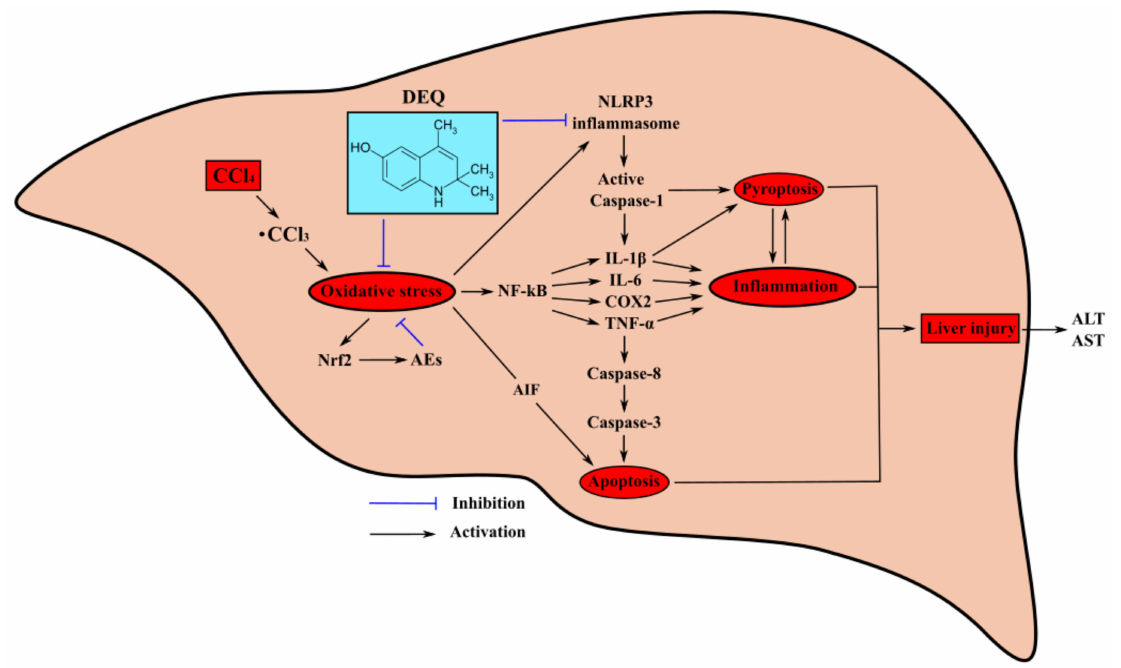
Figure 8. Schematic illustration of DEQ-mediated protective effects against CCl 4 -induced hepatotoxicity. Reactive oxygen species (ROS) formation during CCl 4 administration induces hepatic pyroptosis and apoptosis via the activation of NLRP3 inflammasome, pro-inflammatory enzymes, and cytokines. Hepatoprotective effects of DEQ are based on the suppression of intensification of oxidative stress and activation of NLRP3 inflammasome through several cascades of molecular processes sufficient to improve acute injury outcomes of CCl 4 -induced